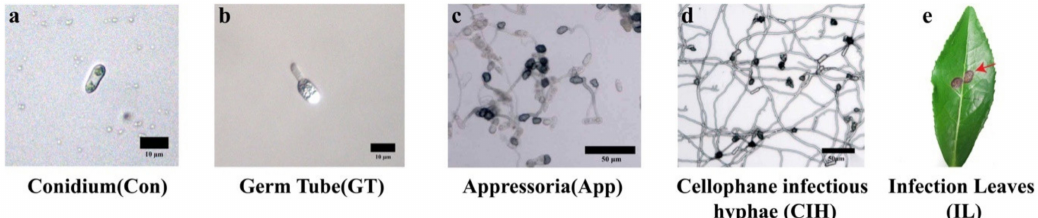
Figure 1. Morphology detection of C. camelliae in the di ff erent growth stages. ( a ) conidium (Con) morphology, bars = 10 µ m; ( b ) germ tube (GT) morphology (2 hpi), bars = 10 µ m; ( c ) dark-domed appressorium (App) morphology (8 hpi), bars = 50 µ m; ( d ) cellophane infectious hyphae (CIH) morphology (36 hpi), bars = 50 µ m; ( e ) infection leaf (IL) lesion morphology (72 hpi). (hpi: hours